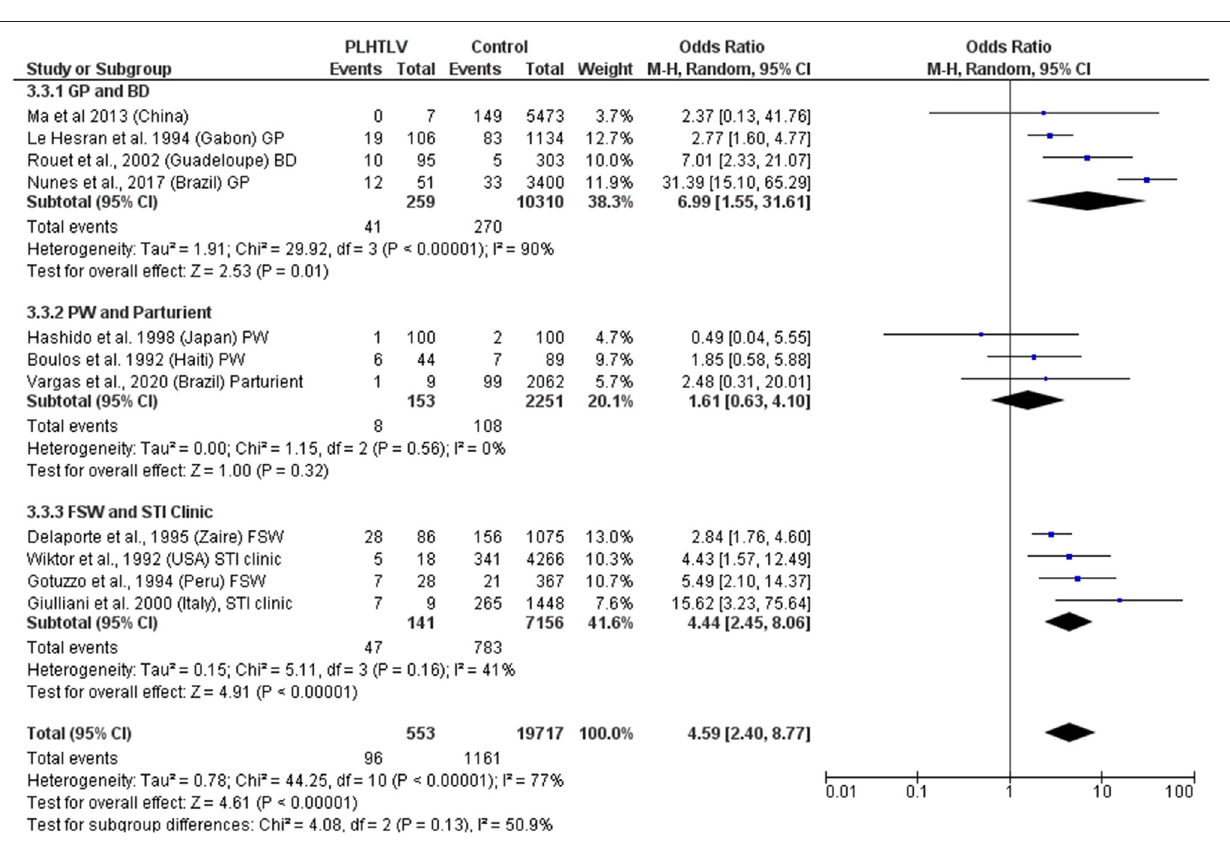
An association has also been observed between HTLV-1 and seropositivity for Chlamydia trachomatis (C. trachomatis) amongst Peruvian female sex workers (with an OR =